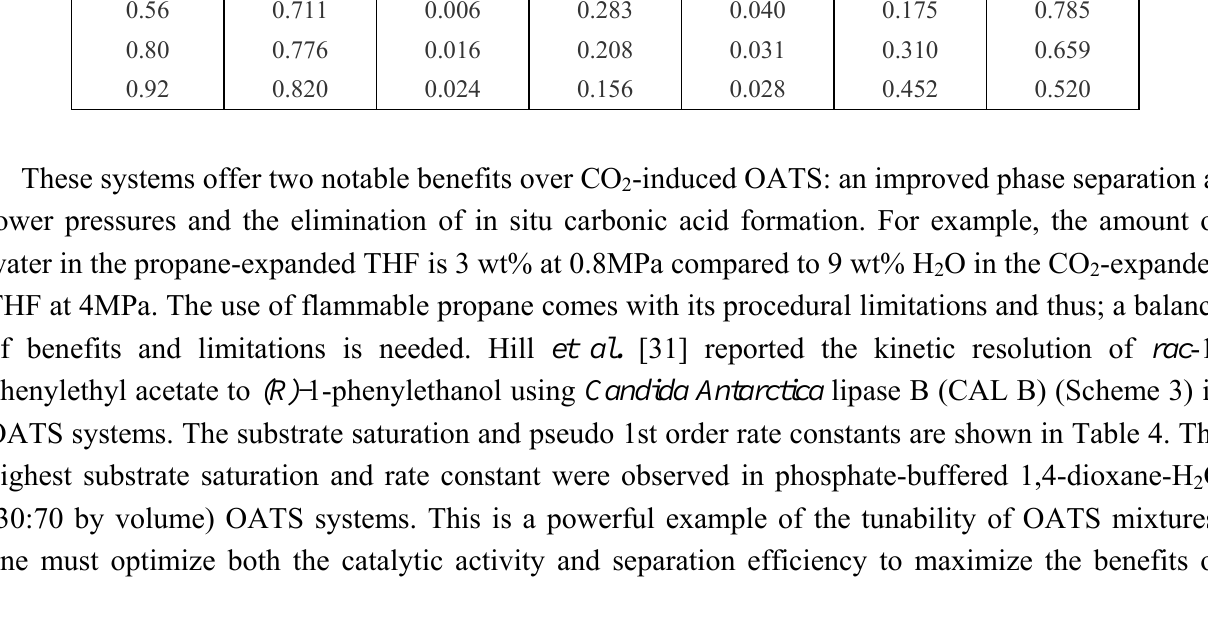
Table 3. Liquid-liquid equilibria of H P